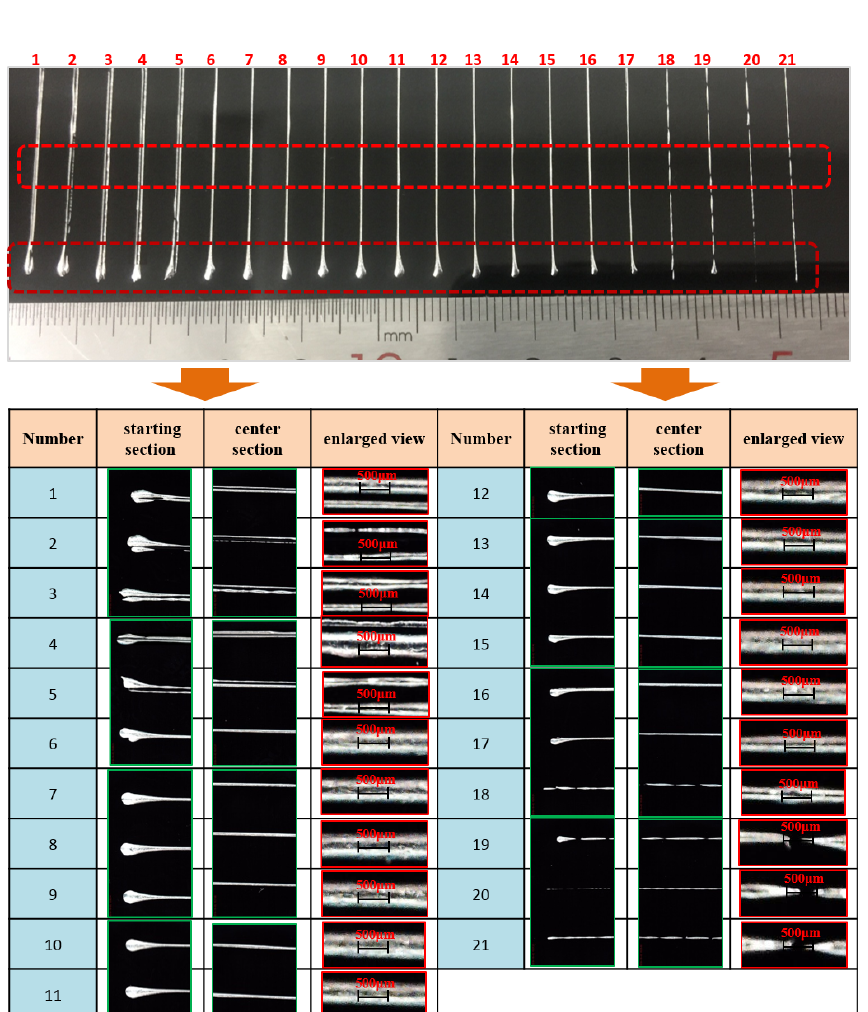
Figure 7. The direct-writing lines with different writing